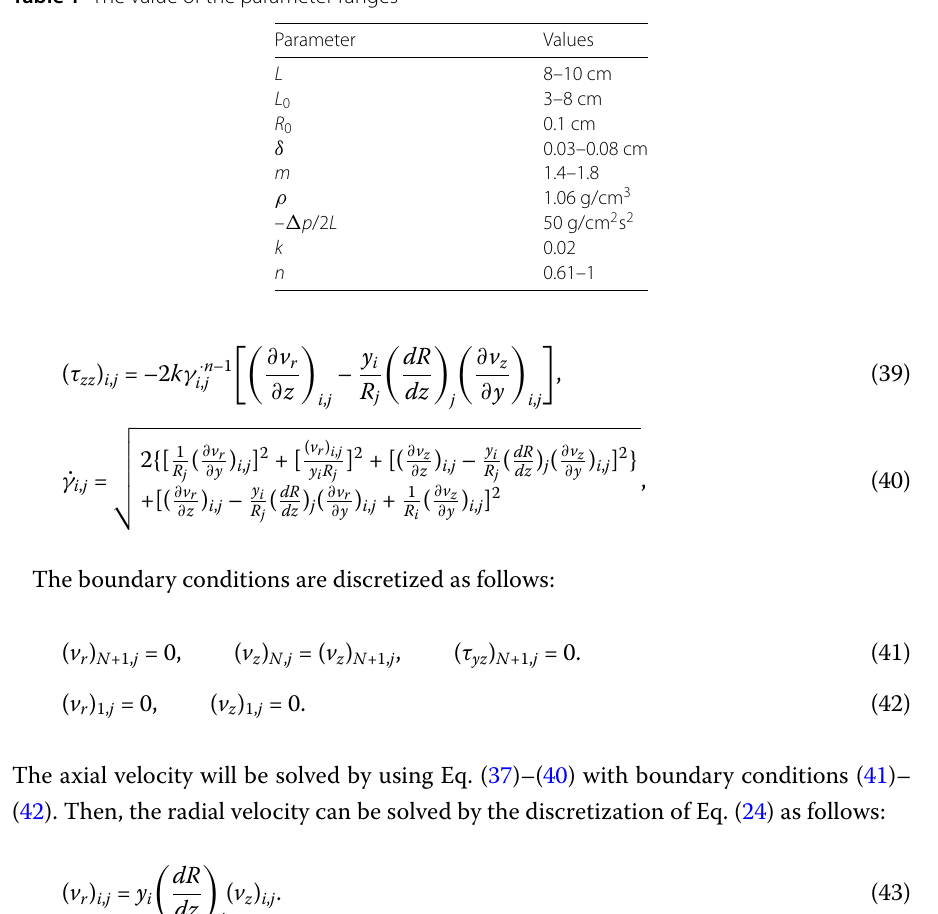
Table 1 The value of the parameter